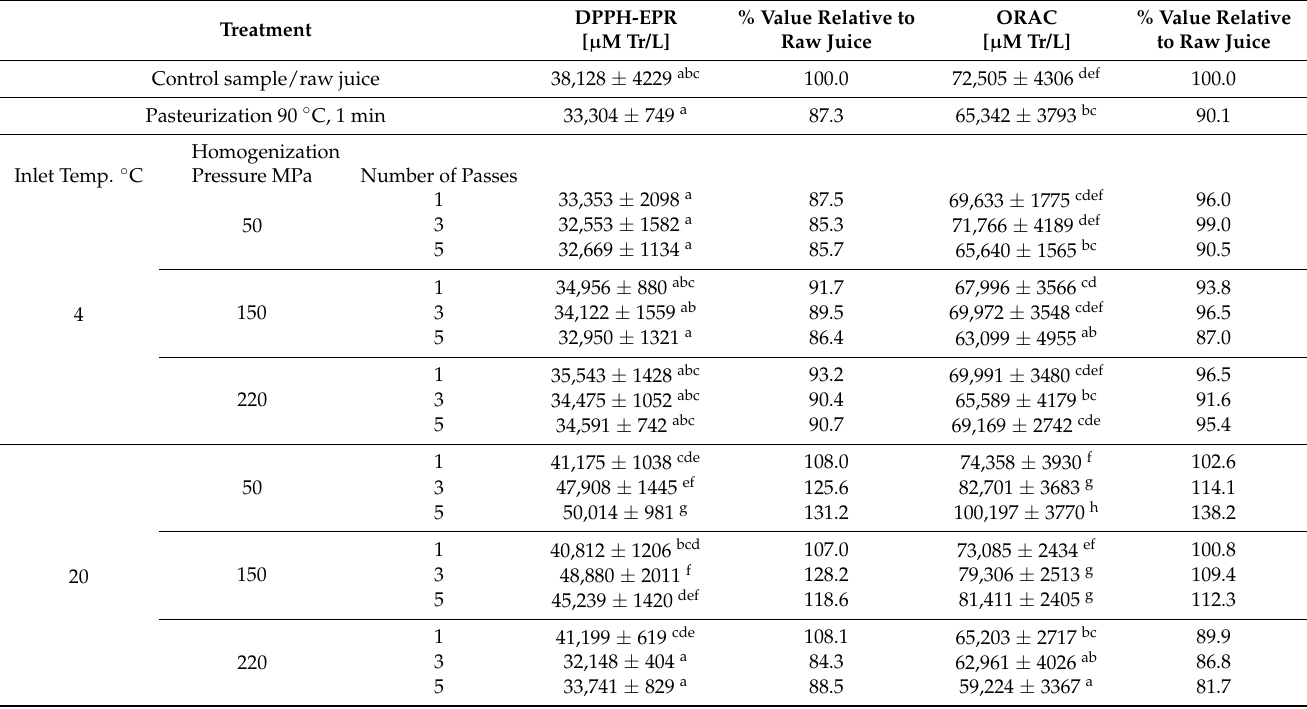
Table 4. Antioxidant capacity of cloudy blackcurrant juice samples treated with high-pressure homogenization or